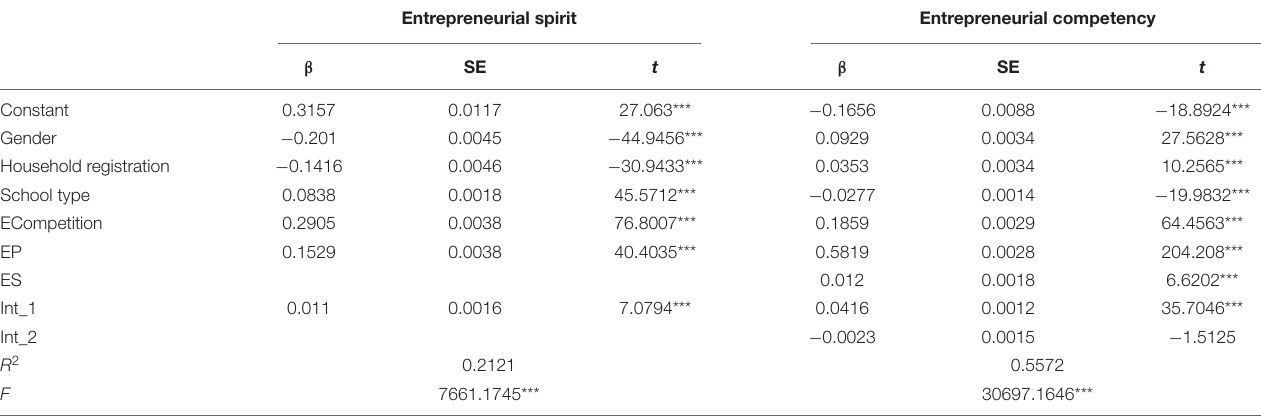
TABLE 6 | A moderated mediation test